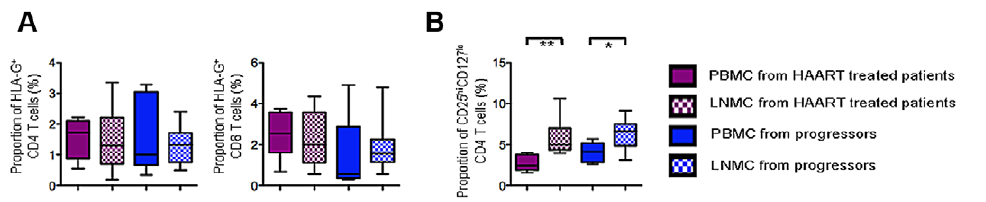
Figure 2. Analysis of HLA-G + Treg in lymph nodes and peripheral blood during HIV-1 infection. (A) Proportions of HLA-G + CD4 and CD8 Treg in lymph node and peripheral blood samples. (B) Corresponding analysis of the frequencies of classical CD25 hi CD127 lo CD4 Treg in lymph node and peripheral blood samples. Box and Whisker plots represent cumulative data from n=5 PBMC/n=9 LNMC from HAART-treated HIV-1 patients and n=5 PBMC/n=12 LNMC from untreated HIV-1 patients. Significance between groups was tested by Mann Whitney U